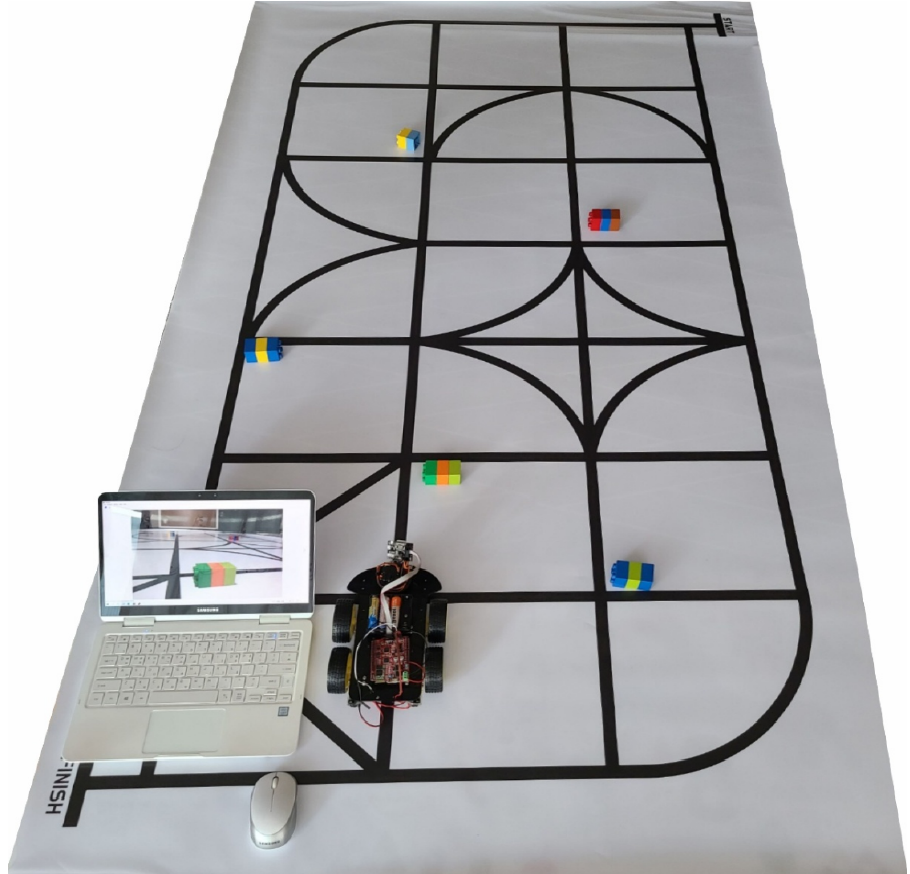
Figure 5. Virtual experimental environment.